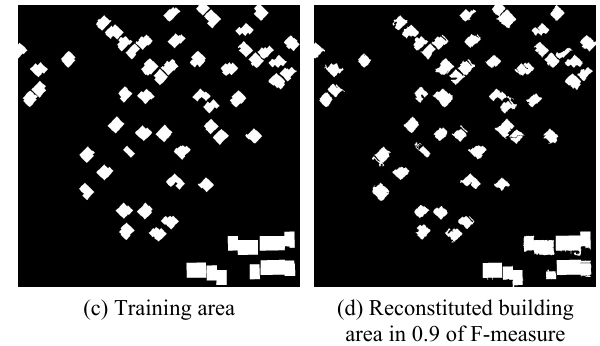
Figure 7. Processing results by automatic parameterization